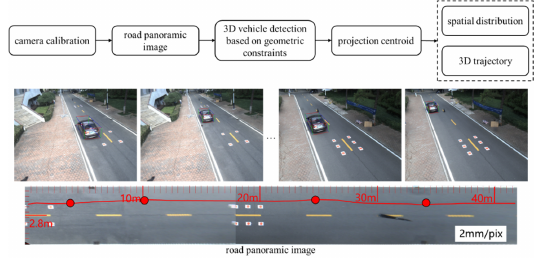
Figure 1. The overall flow chart of the proposed algorithm.